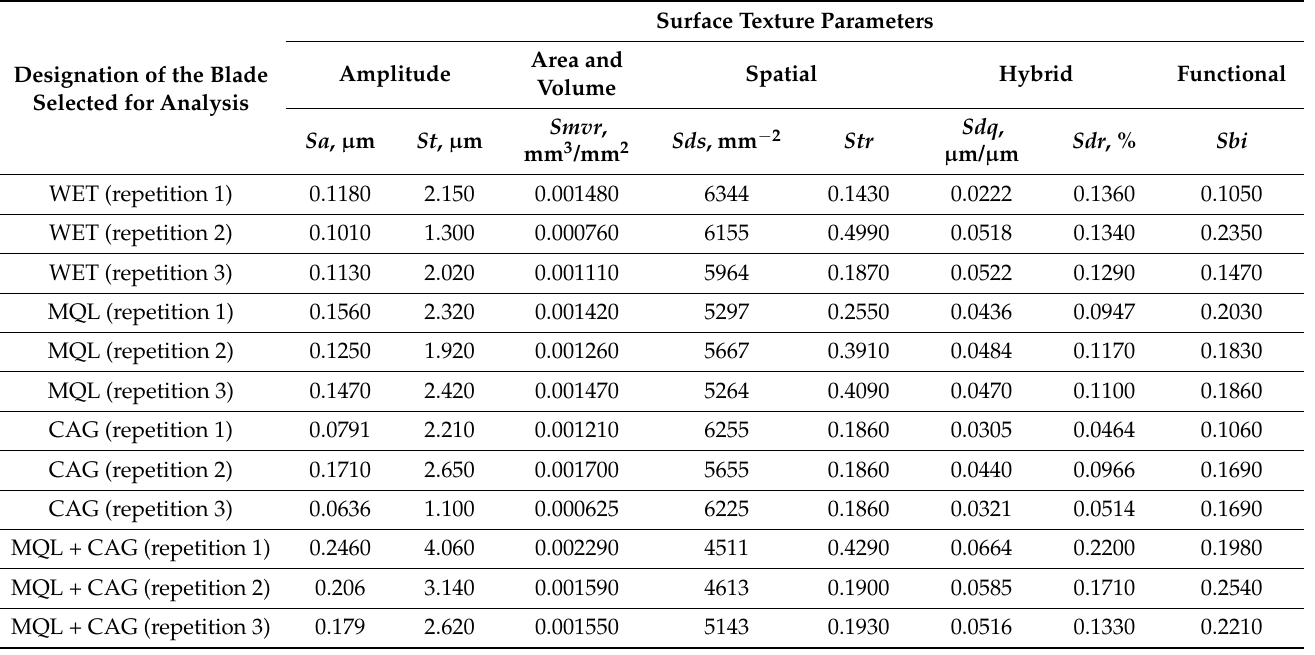
Table 3. Collection of values of selected surface texture parameters of planar knives shaped in experimental studies determined from measurements of blade surface microtopography.